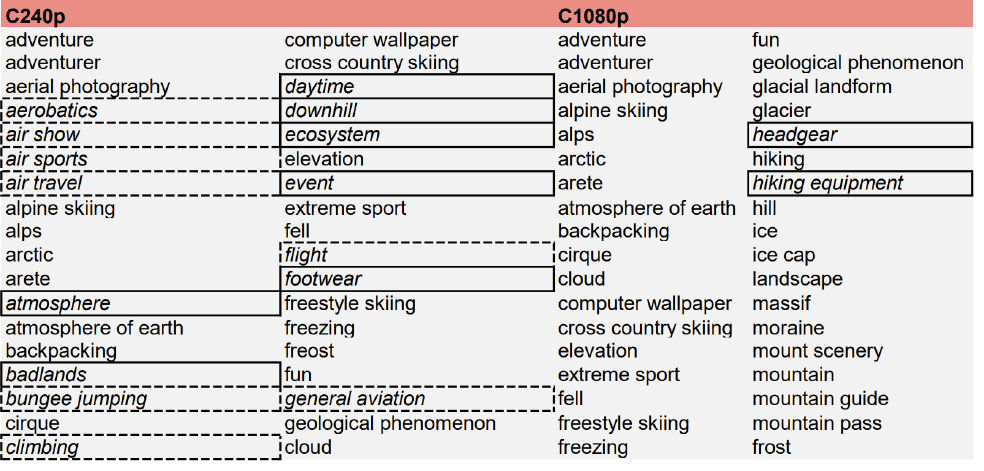
Figure 6. Comparison of labels at 240p and 1080p resolutions for the video C: differing ones in italic, solid border, and non pertinent in italics, dashed